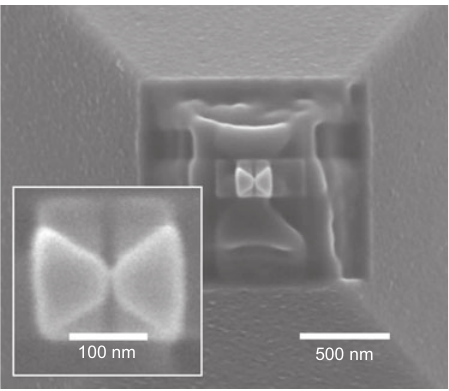
Figure 17 Bow-tie antenna on a cantilever pyramid tip created by focused ion milling [137] . Copyright 2005 by the American Physical Society.